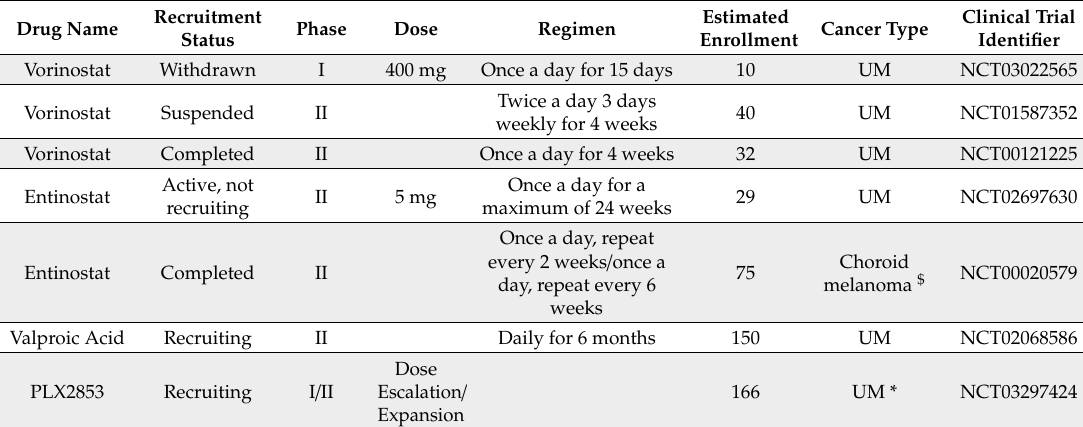
Table 2. Clinical trials of epigenetic drugs in solid tumors, including uveal